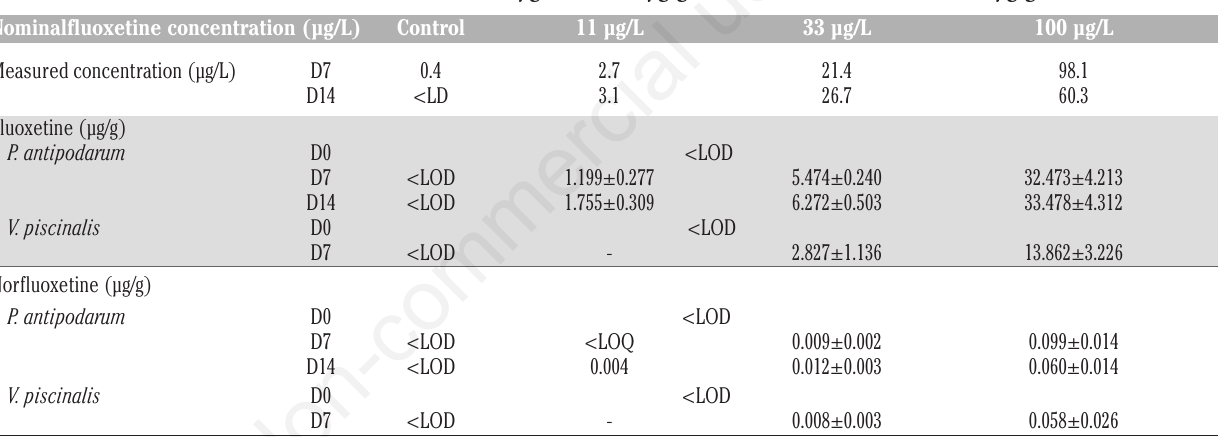
Table 1. Measured concentrations of fluoxetine in water (µg/L), snails (µg/g), and of norfluoxetine in snails (µg/g).